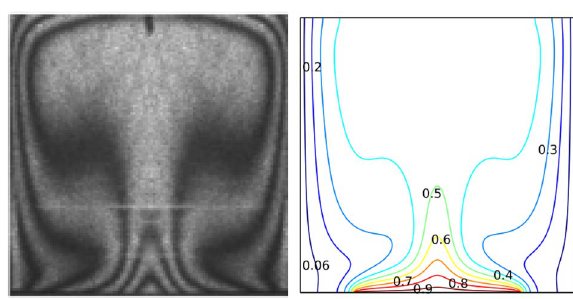
Figure 2. Validation of numerical code with Calcagni et al. 53 at Ra = 10 5